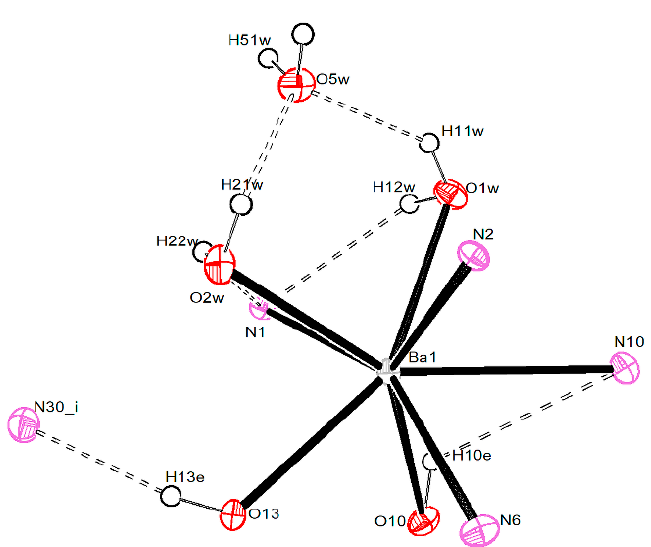
Figure 20 . The first and second coordination spheres of Ba1. Figure 20. The first and second coordination spheres of